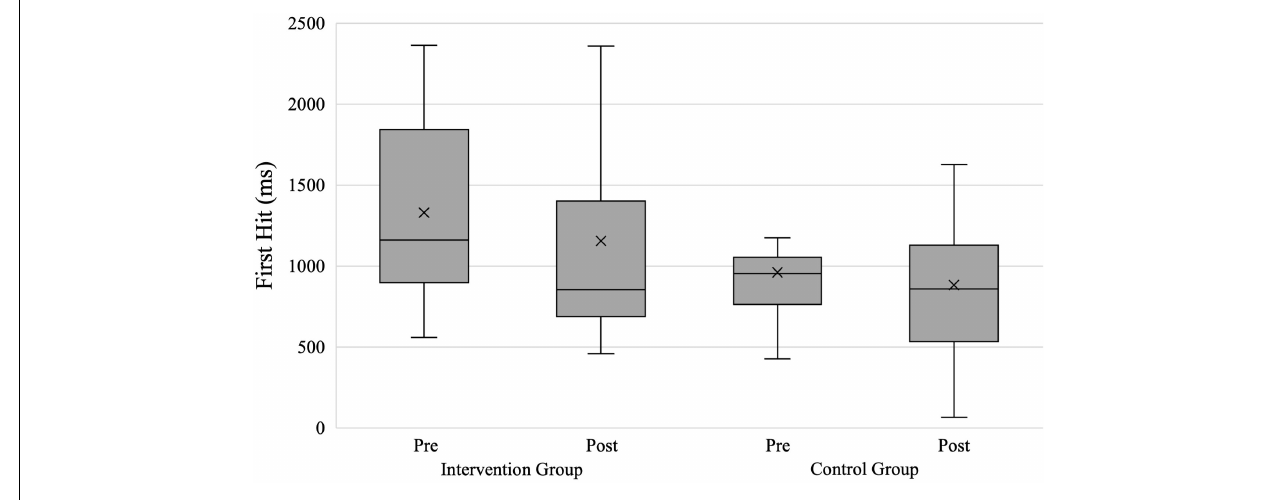
FIGURE 7 | First Hit in shoot scenarios for both groups. X, mean marker.